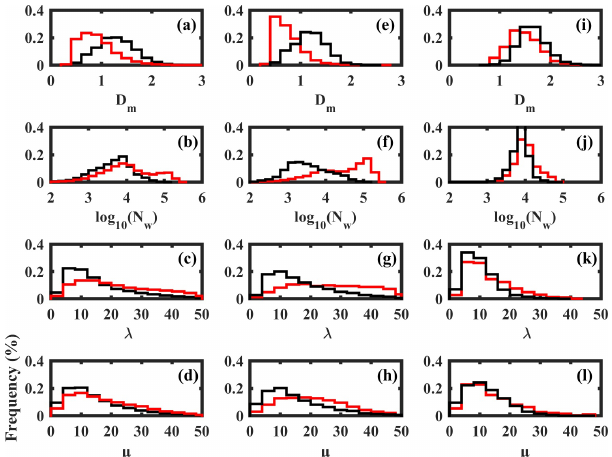
Figure 8. Histograms of (a) D m , (b) log 10 (N w ) , (c) λ , and (d) µ for wet and dry spells. (e–h) Same as (a–d) , but for stratiform rain. (i–l) Same as (a–d) , but for convective rain. Here, the black and red lines represent wet and dry spells,